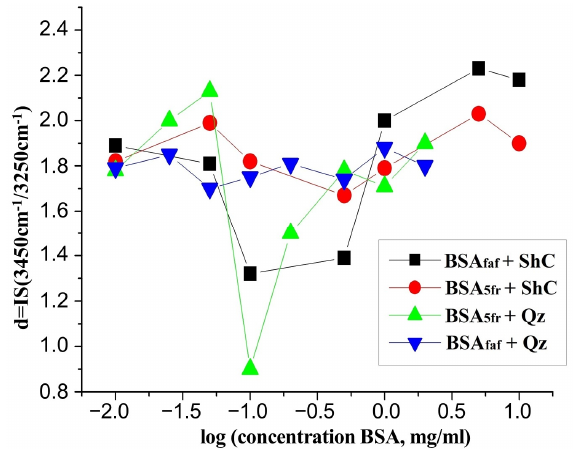
Figure 5. Change in the ratio of the parameter d = IS(3450 cm − 1 )/IS(3250 cm − 1 ) of the Raman spectra of albumin protein (BSA) dispersions depending on the concentration in the presence of nanoparticles of ShC and Qz, top to bottom:fatty acid-free BSA faf + ShC;native BSA 5fr + ShC;native BSA 5fr + Qz; and fatty acid-freeBSA faf + Qz. The relative error in determining the ratio did not exceed 10%.